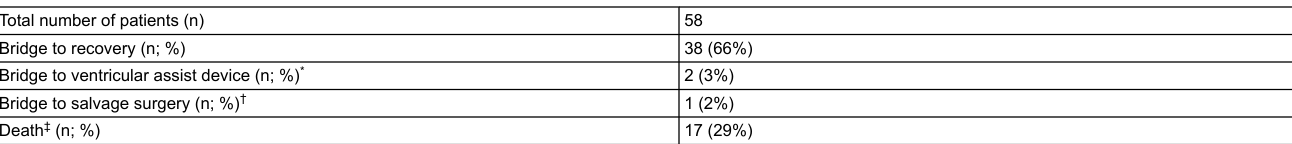
Days on ICU (median (min, max)) Days in hospital (median (min, max)) Days of follow-up (median (min, max)) Upgrading of ECMO (n; % of group) Cannula change ECMO (n; % of group) Weaning from ECMO (n; % of group) Survival during transport (n; % of group) Survival to hospital discharge (n; % of group) Overall survival (n; % of group)